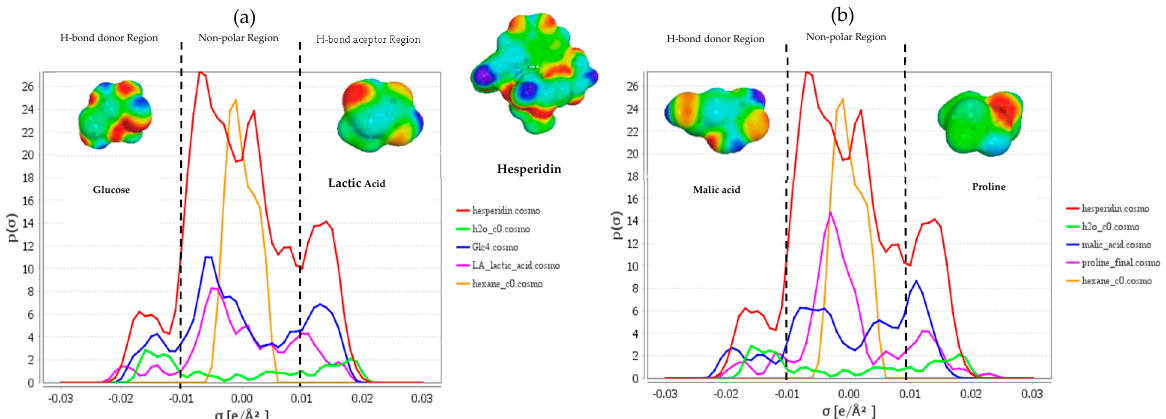
Figure 1. ( a ) Sigma profile of hesperidin (red), water (green), glucose (blue), lactic acid (pink), and hexane (orange). ( b ) Sigma profile of hesperidin (red), water (green), malic acid (blue), L-proline (pink), and hexane (orange) and their sigma surfaces. H-bond, hydrogen bond.